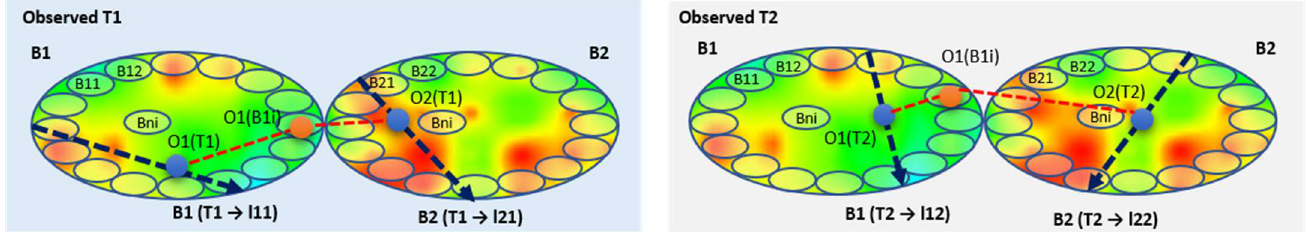
Figure 4. The case of different results at different times and F-Ser-Beams.